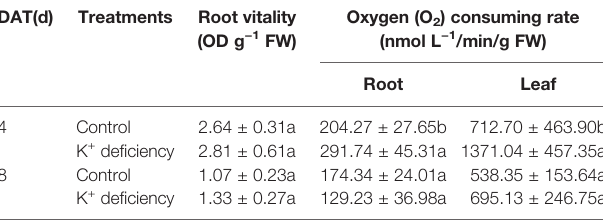
TABLE 3 | Effect of K + de fi ciency on root vitality, root or leaf respiration re fl ected by oxygen consumption rate at 4/8 days after transfer day (DAT). Oxygen (O 2 ) consuming rate DAT(d) Treatments Root vitality (nmol L − 1 /min/g FW) (OD g − 1 FW) Root Leaf